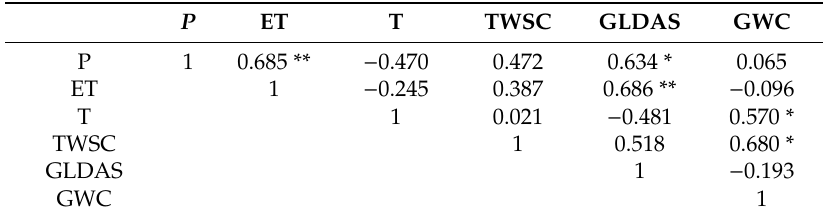
Table 2. Correlation between hydrological factors at annual scale.